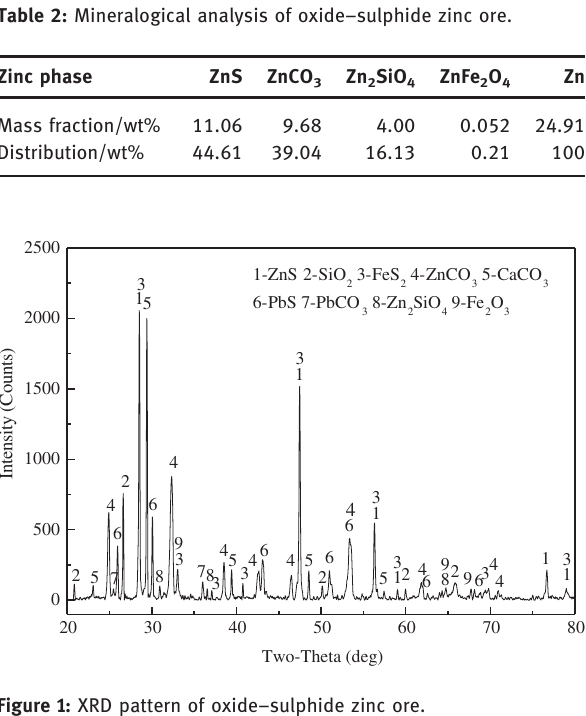
Figure 1: XRD pattern of oxide – sulphide zinc